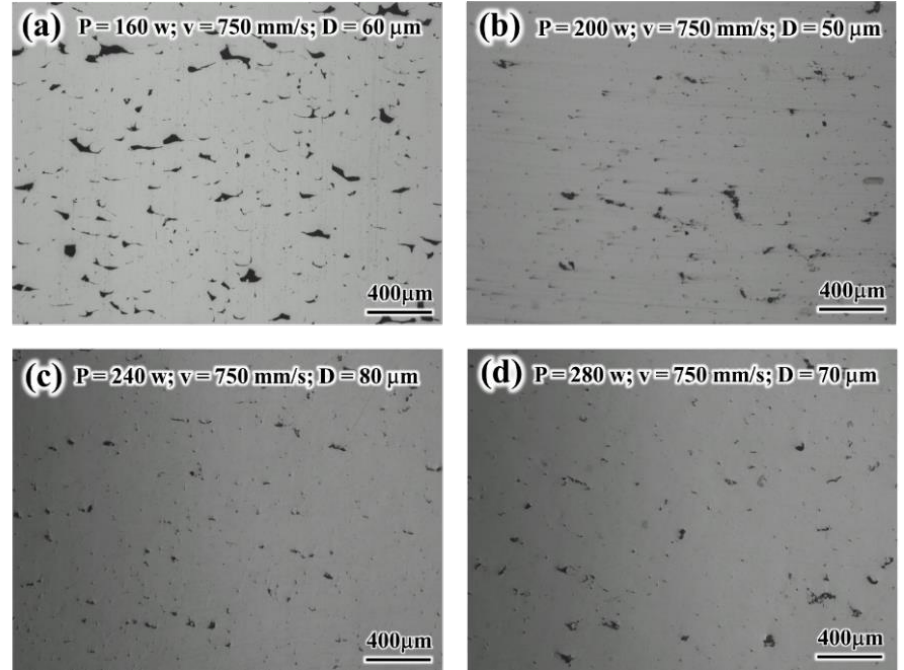
Figure 6. Optical micrograph of sample: ( a ) No. 2, ( b ) No. 6, ( c ) No. 10, ( d ) No. 14.